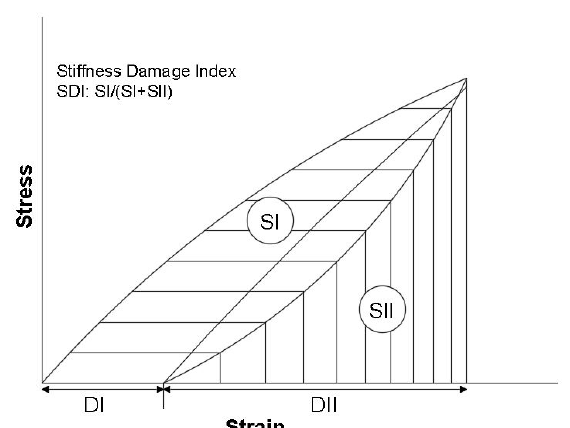
Figure 4. Stiffness Damage Test (SDT): Stiffness Damage Index (SDI) and Plastic Deformation Index (PDI) [19],